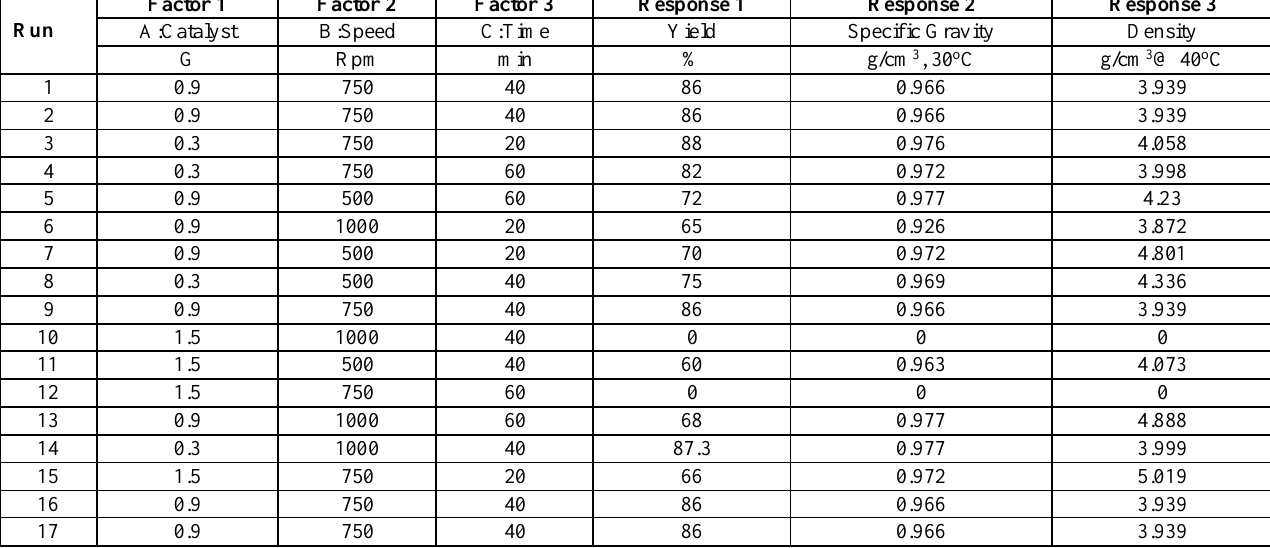
Table 2: Design experimental matrix at different catalyst concentrations, speeds and